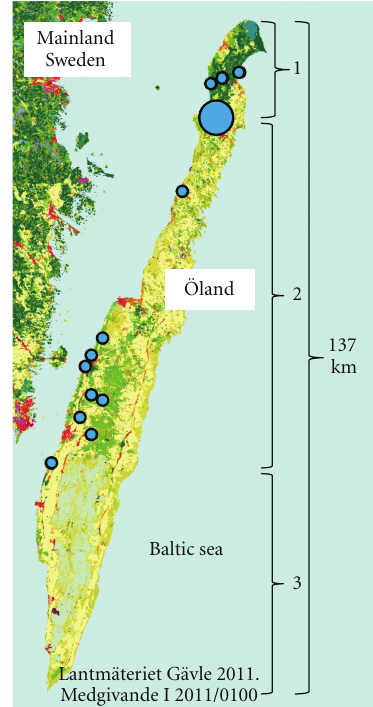
Figure 1: Landscape types (1 = mixed or coniferous forest, 2 = deciduous forest, 3 = agricultural land) and distribution of Ficedula flycatcher nest-box areas (blue circles) on the Swedish island of ¨Oland. The large circle represents nine nest-box areas surrounding the town of L¨ottorp where collared flycatchers started to colonize the island (and where pied flycatchers were already present) in the late 1950s–early 1960s. Collared flycatchers now outnumber pied flycatchers in this area ( ∼ 90% collared flycatchers). The relative proportion of collared flycatchers gradually declines southward. Two of the nest-box areas in the north of the island are dominated by coniferous forest and so far only inhabited by pied